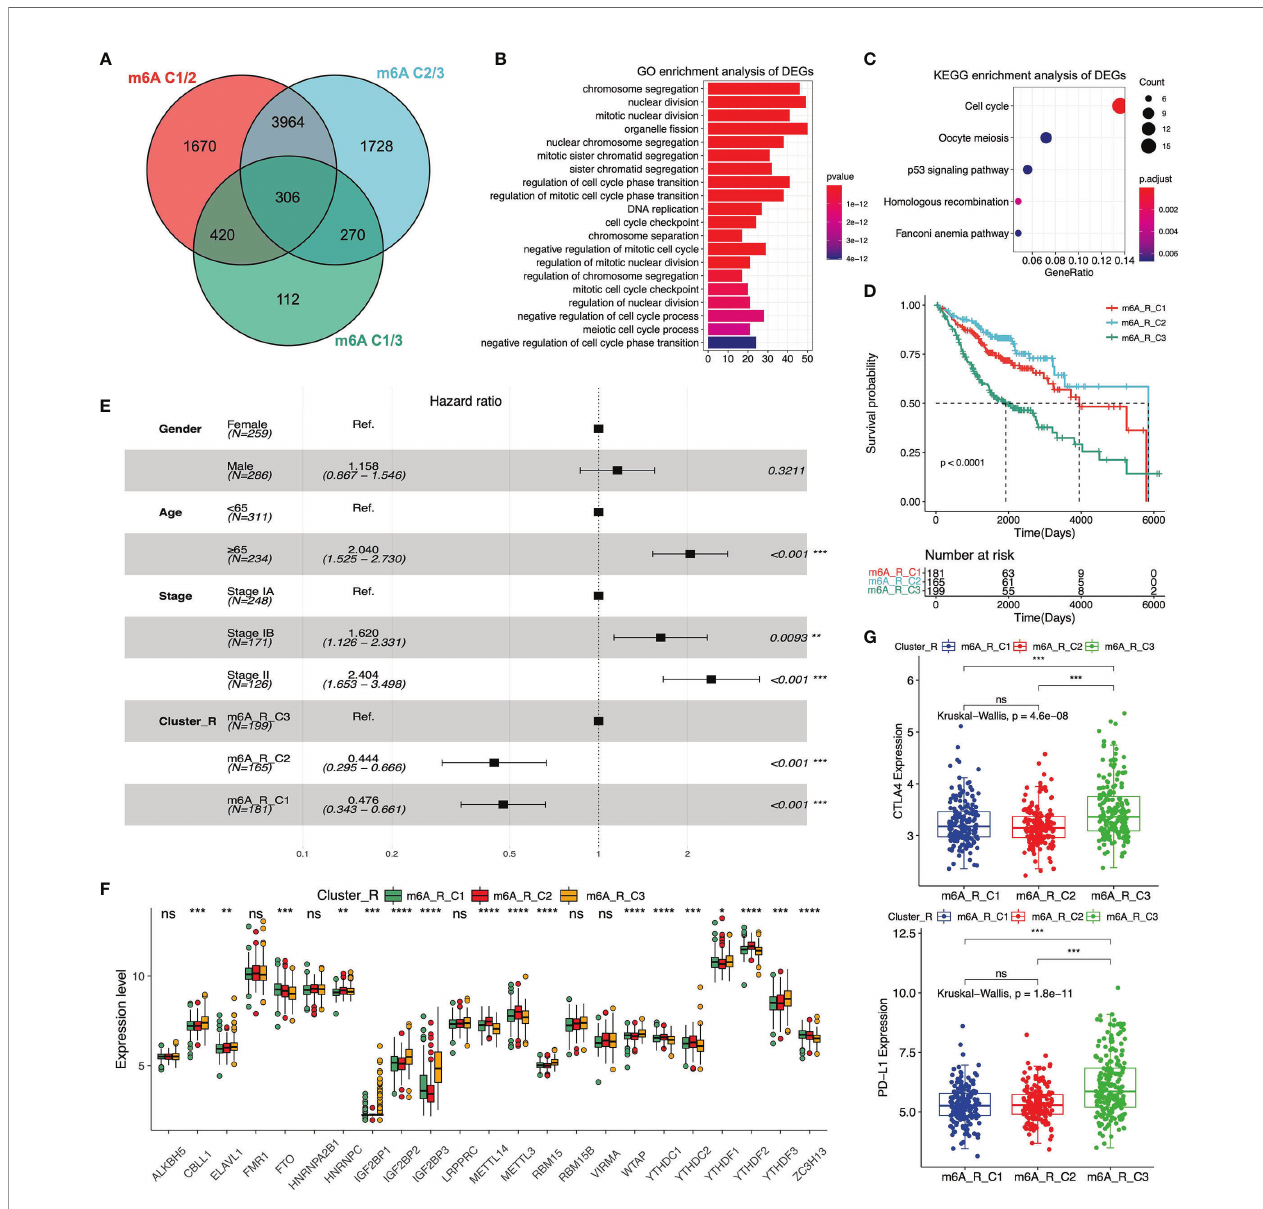
FIGURE 3 | Analysis of differentially expressed genes (DEGs) among three m 6 A clusters and enrichment analysis in meta-GEO cohort. (A) The Venn diagram reveals the m 6 A correlated differentially expressed genes. (B) GO enrichment analysis of the DEGs among three clusters. (C) KEGG enrichment analysis of the DEGs among three clusters. (D) The Kaplan-Meier curves of three m 6 A gene-related clusters via Log-rank test. (E) Multivariate Cox regression analysis of clinical parameters among three m 6 A gene-related clusters. 95% con fi dence interval was symbolized by the horizontal line. Hazard ratio (HR) was symbolized by the vertical dotted line. (F) The 23 m 6 A regulators ’ expression among three m 6 A gene-related clusters. (G) The expression levels of CTLA-4 and PD-L1 among three m 6 A gene-related clusters. *P < 0.05; **P < 0.01; ***P < 0.001; ****P < 0.0001; ns, not signi fi